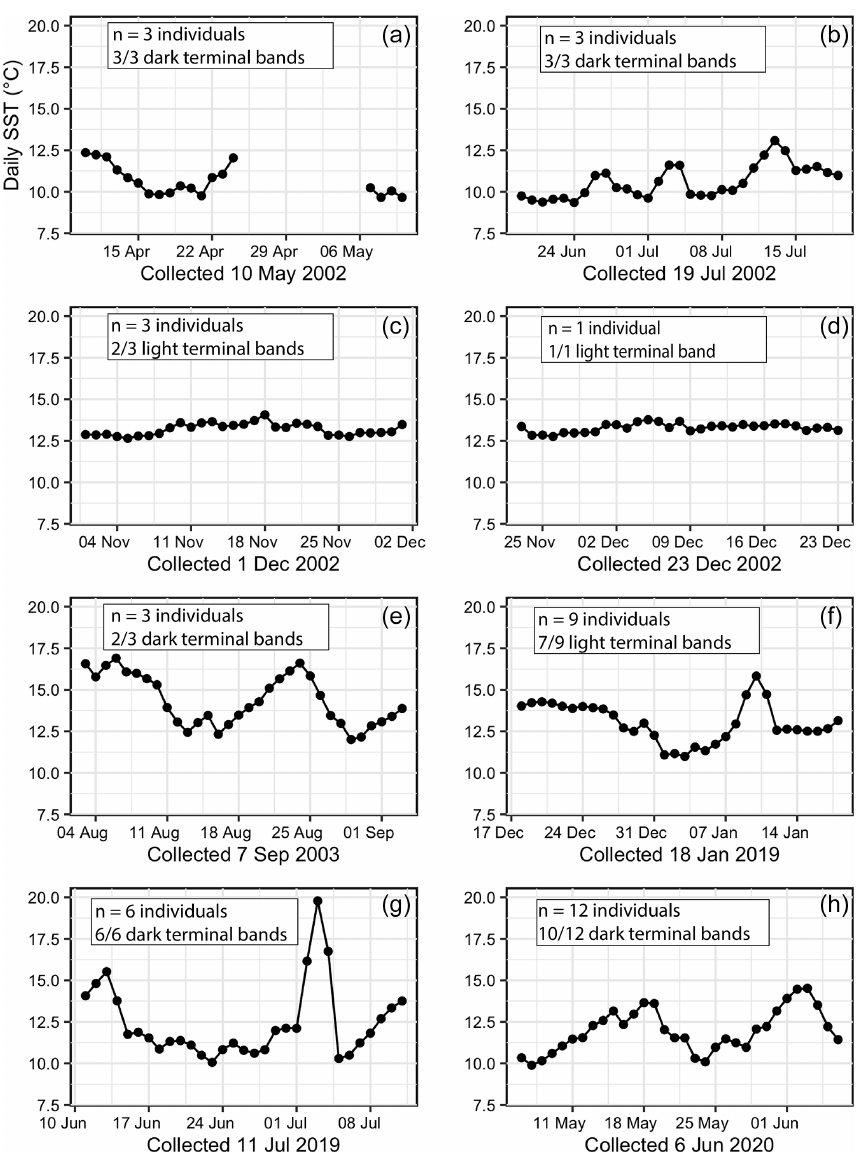
Figure 7. Daily temperatures for 30d prior to the collection date for all 40 specimens. Each plot features the number of specimens collected on that date and the majority terminal-band color. (a) Instrumental error occurred in May 2002. (b) Daily temperatures oscillating between cooler ( ∼ 9 ◦ C) and warmer ( ∼ 13 ◦ C) in July 2002. (c,d) Consistent daily temperatures between 12.25 and 12.5 ◦ C in December 2002. (e) Sinusoidal daily temperatures oscillating between ∼ 12 and 17.5 ◦ C in September 2003. (f) Daily temperatures prior to the 18 January 2019 collection date were consistent for 2 weeks before slight cooling and 3d of warming. (g) Highly variable daily temperatures and a 3d extreme warm spike in July 2019. (h) Daily temperatures oscillating between cooler ( ∼ 10 ◦ C) and warmer ( ∼ 15 ◦ C) in June